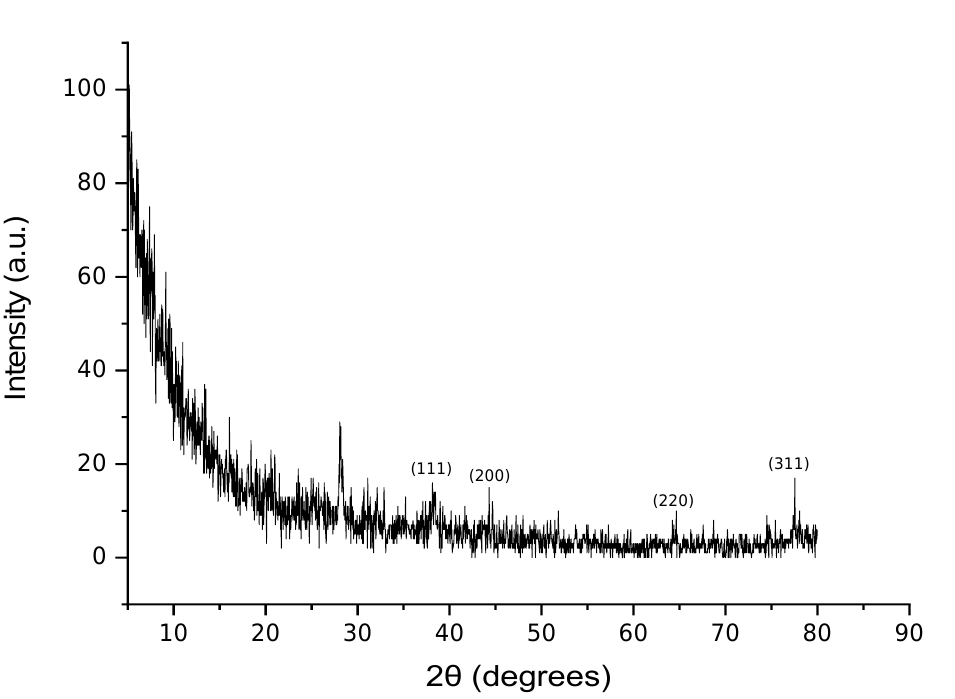
Figure 7. XRD spectrum of silver nanoparticles biosynthesized using aqueous peel extract of Punica granatum .